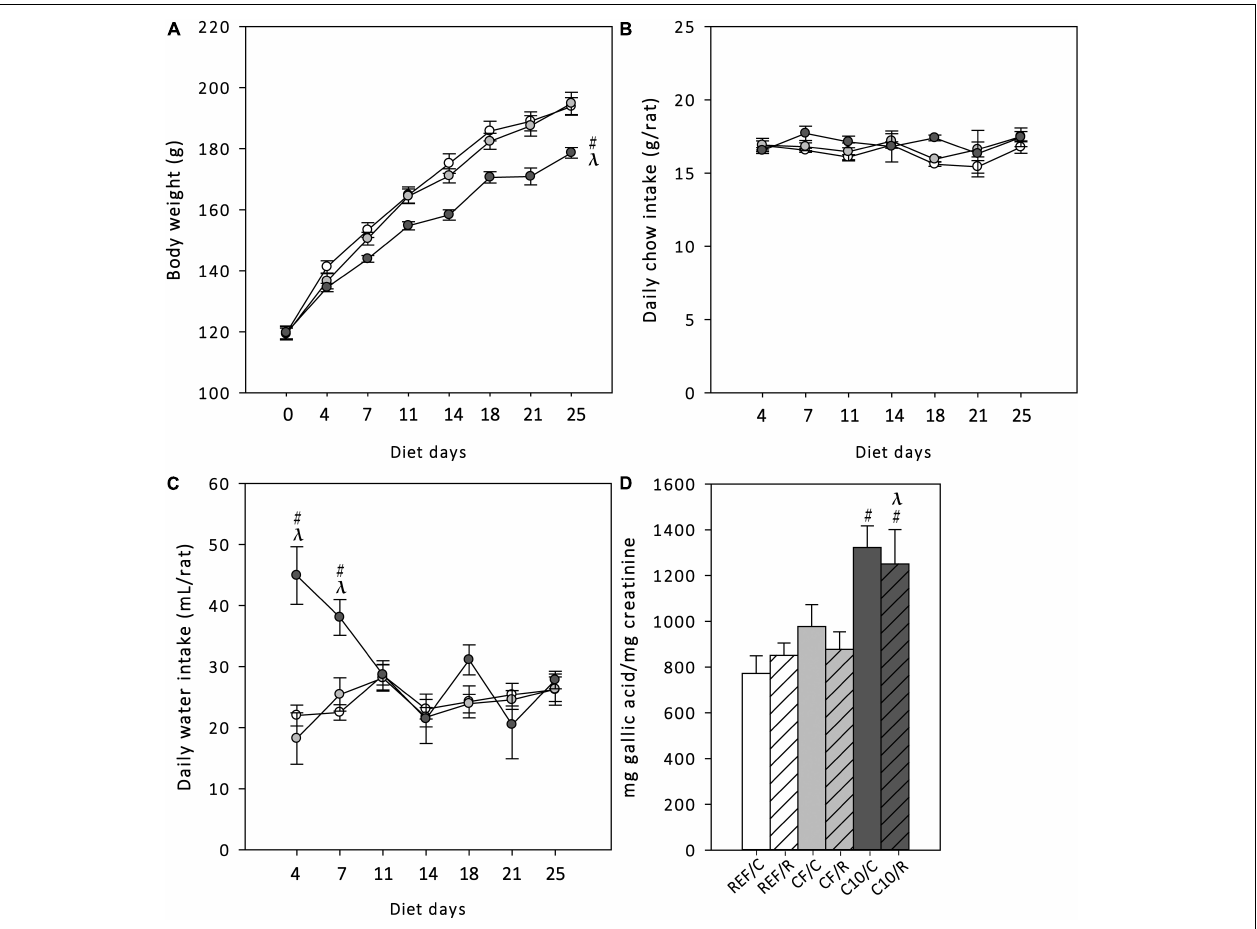
FIGURE 1 | Body weight (A) , chow intake (B) and water intake (C) throughout the 25-day dietary intervention period, and urine total polyphenol content at the end of the study (D) . REF, reference diet; CF, 5% cocoa fiber-enriched diet; C10, 10% cocoa-enriched diet. The REF groups are represented by white symbols ( ) or white bars, the CF groups by gray symbols ( ) or gray bars and the C10 by black symbols ( ) or black bars. In (D) , the sedentary control groups (C) are represented (cid:35) by smooth bars and the runner groups (R) by striped bars. Data are expressed as mean ± SEM ( n = 8). Statistical differences [repeated measures ANOVA test (cid:32) (cid:32) followed for (A–C) and Kruskal-Wallis followed by Dunnet’s test for (D) ]: # p < 0.05 vs. REF diet; λ p < 0.05 vs. CF diet.